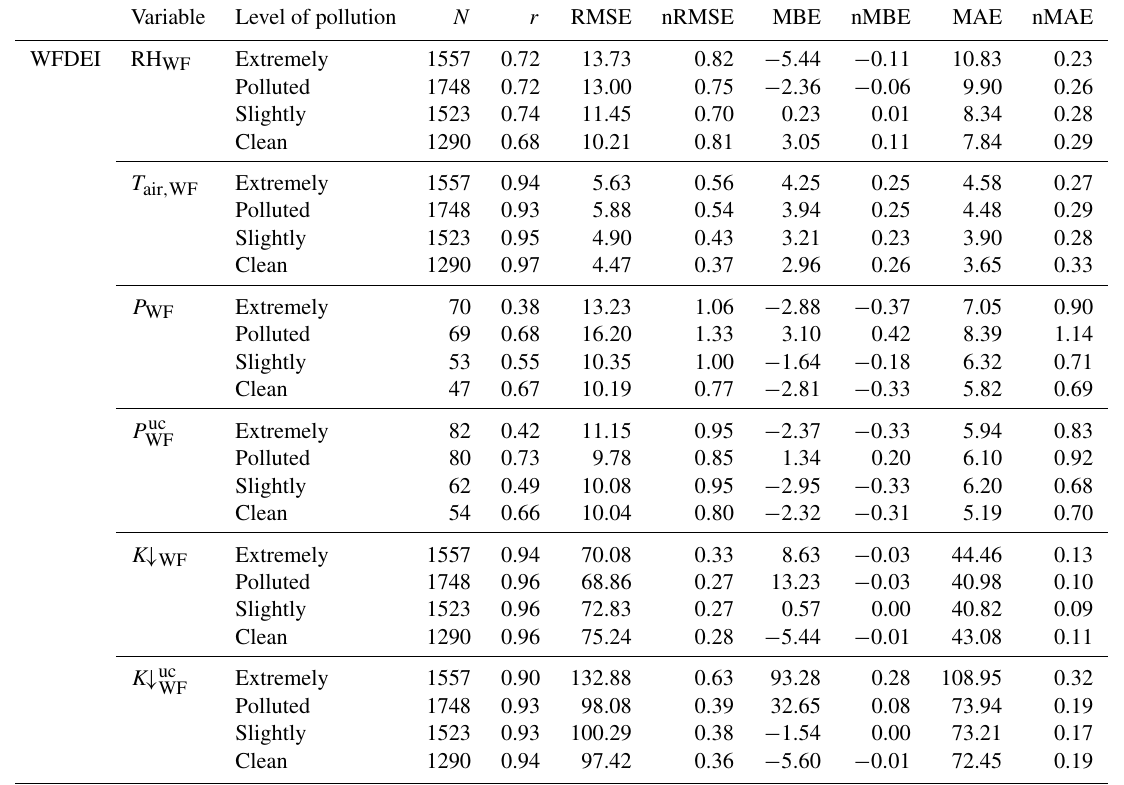
Table 3. Comparison for 2006–2009 of WFDEI meteorological variables with observations, stratified by pollution level (extremely